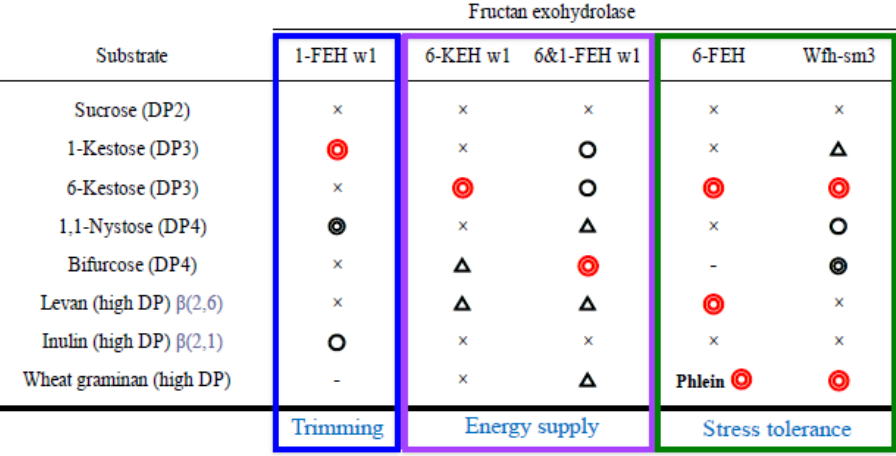
Figure 2. Substrate specificities of wheat FEHs and their supposed roles. Symbols show the degradation levels with recombinant enzymes produced by Pichia pastoris : Red double circle, most highly hydrolyzed; black double circle, highly hydrolyzed; circle, hydrolyzed; triangle, weakly hydrolyzed; cross, hardly hydrolyzed; not examined. References of genes: 1-FEHw1 [46] , 6-KEHw1 [50] , 6&1-FEH w1 [49], 6-FEH [46], and Wfh-sm3 [51] .